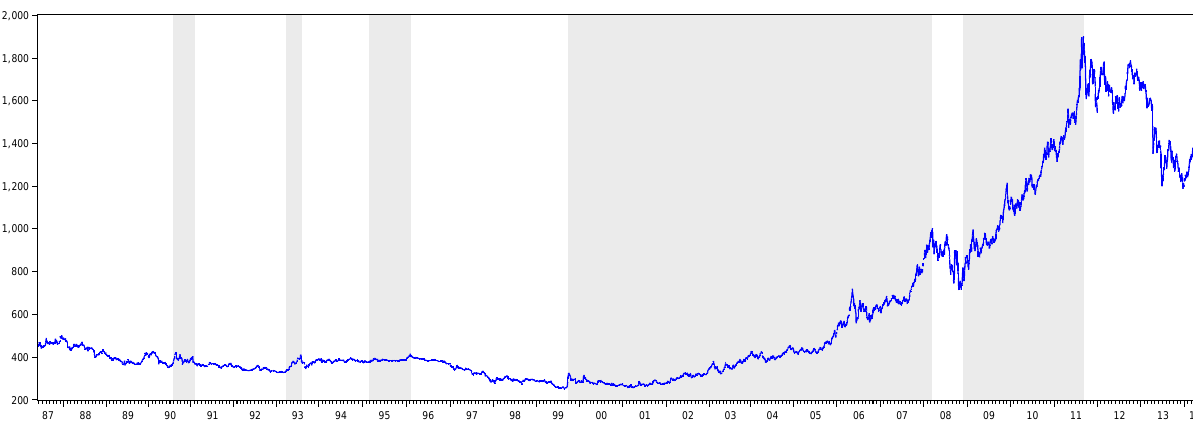
Figure 2. Bull and bear periods of the gold market.